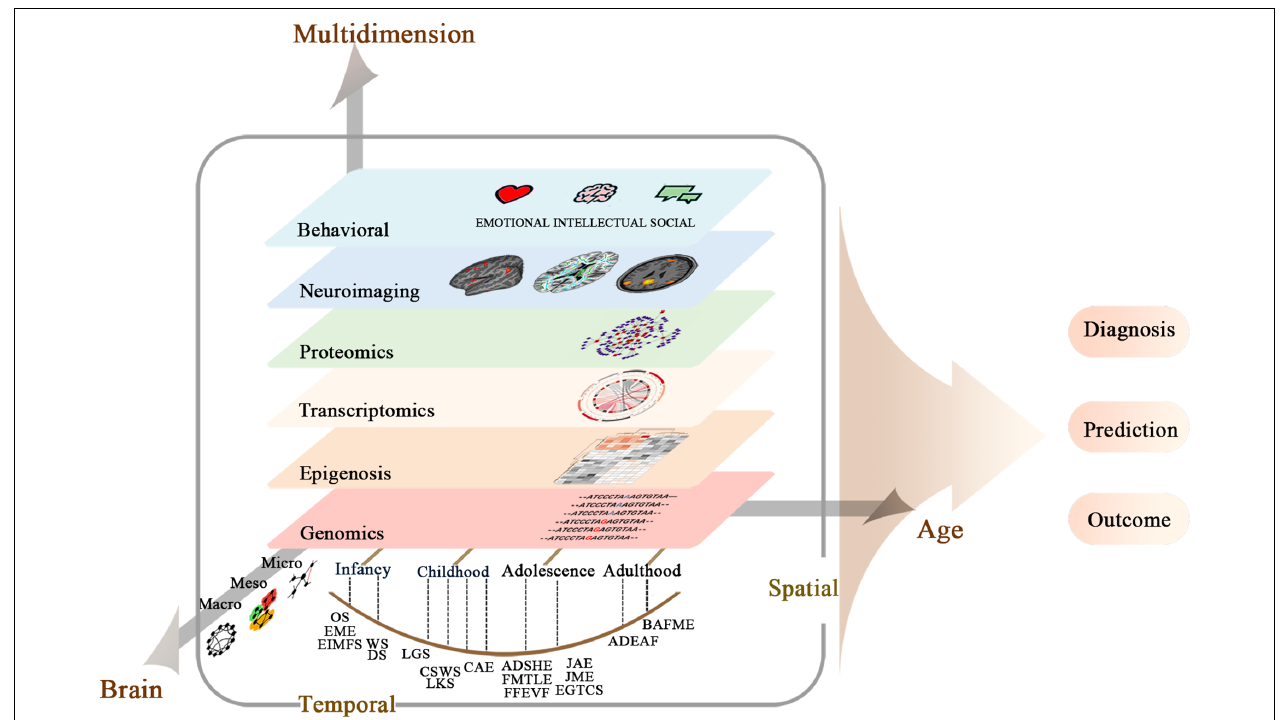
FIGURE 1 | Multi-scale and multi-dimensional approaches for system understanding of neural mechanisms of epilepsy